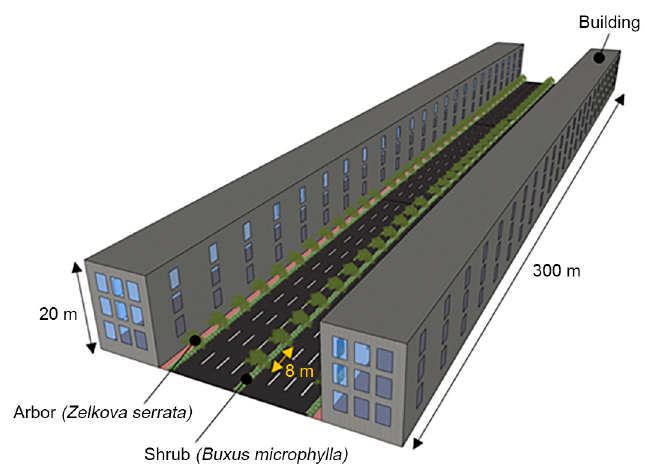
Figure 4. Simulation of the structure of the street and street trees.